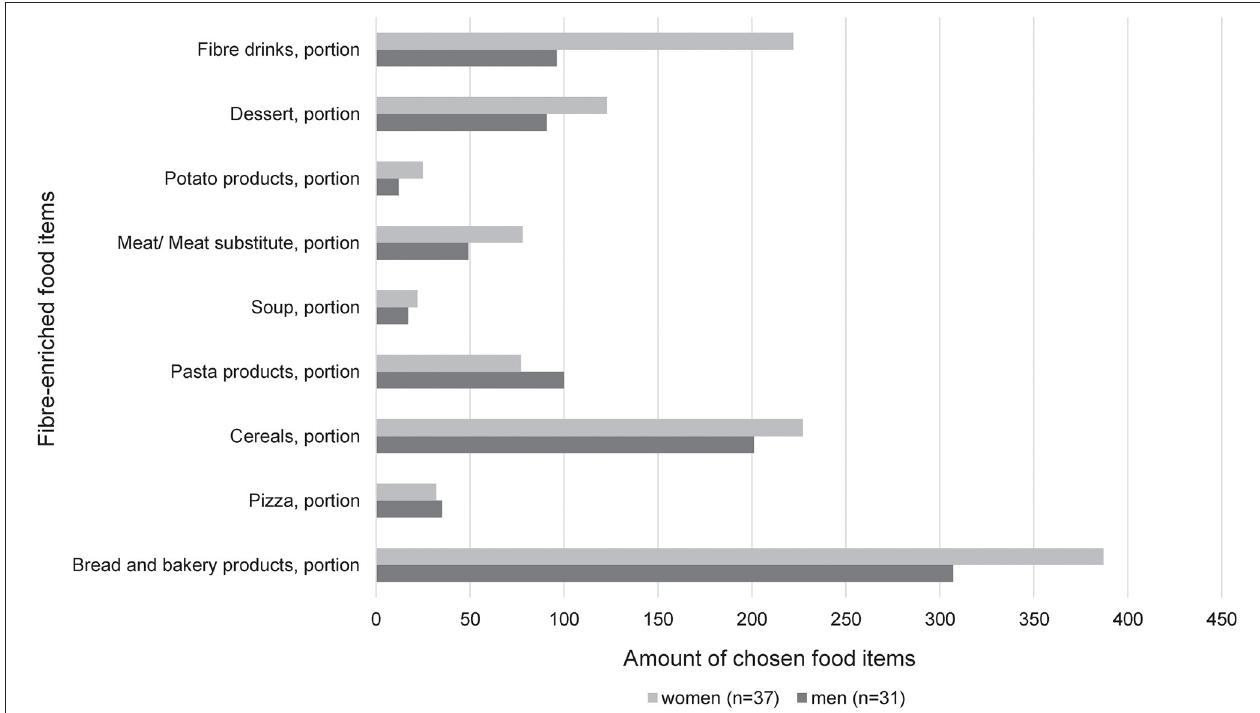
FIGURE 3 | Relative contribution of the various fiber-enriched food groups by sex in the intervention group [women ( n = 37); men ( n = 31)]. The consumption of the different products was obtained 1 week before visit 2, respectively, visit 3. The portion size of each food item is listed in Supplementary Table 1 .